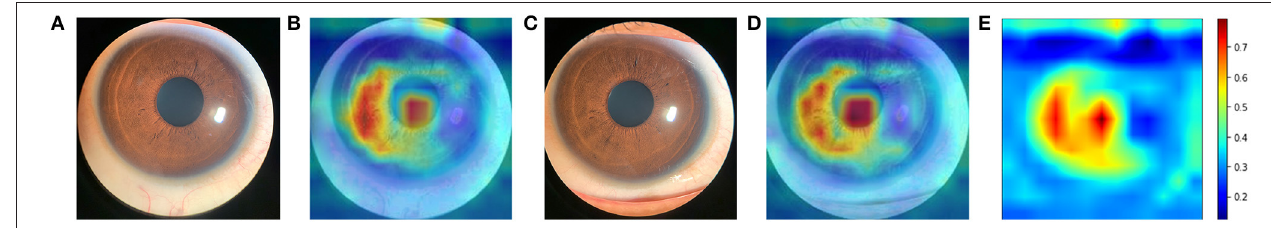
FIGURE 4 | Averaged heatmap shows the regions of the anterior segment photograph that were most important for the deep learning algorithm predictions in test set. Hotter colors (reds) indicate higher activity while cooler colors (blues) represent lower activity. (A) an example of original anterior segment photograph (right eye) obtained by iPhone Xs; (B) the heatmap of the corresponding photograph; (C) an example of original anterior segment photograph (left eye); (D) the heatmap of the corresponding photograph; (E) averaged heat map crossed all images ( n =